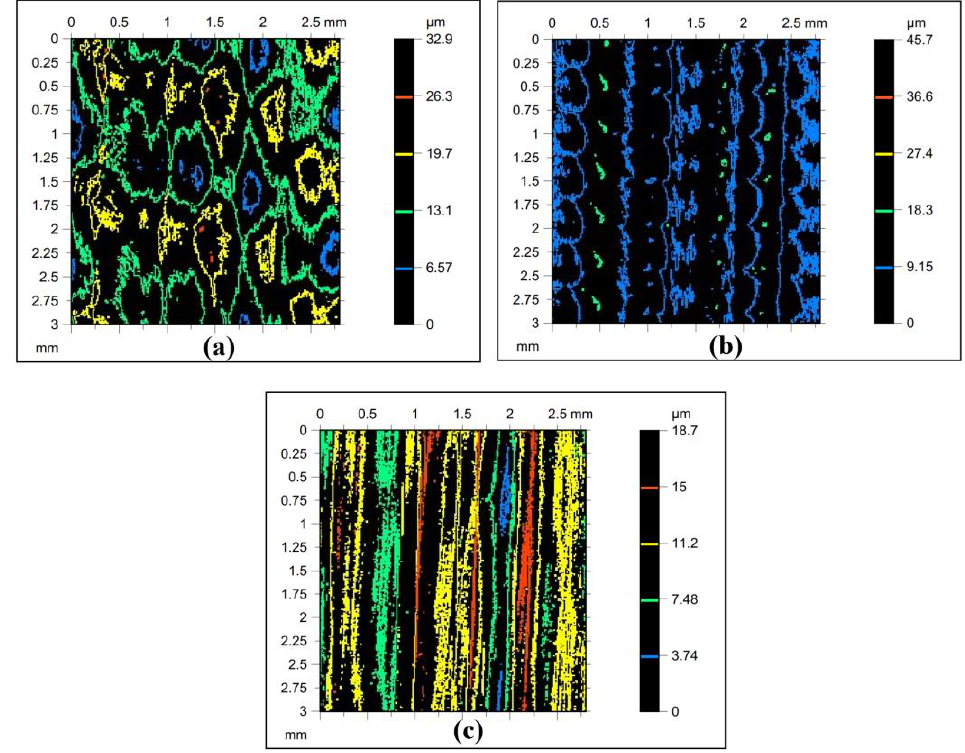
Figure 5. Contour plot of the surface at ( a ) n = 300 rpm, f = 300 mm/min; ( b ) n = 1500 rpm, f = 3000 mm/min; ( c ) n = 1500 rpm, f = 300 mm/min.